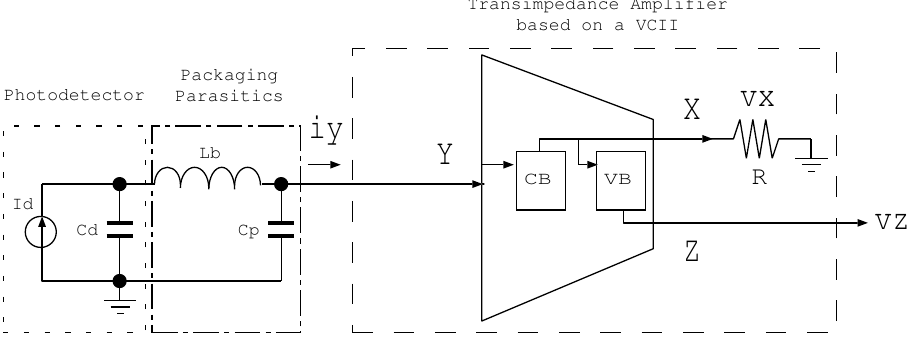
Figure 1. Schematic of a TIA based on VCII, including the packaging of parasitic elements as front-end receivers for converting currents to